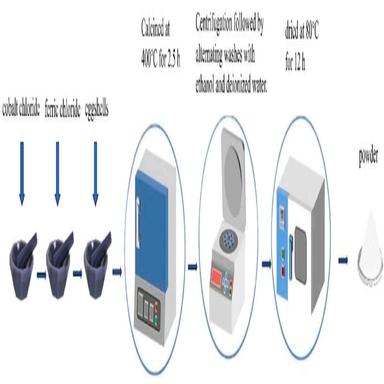
Schematic representation of synthesis steps of CoFe@Eggshell.